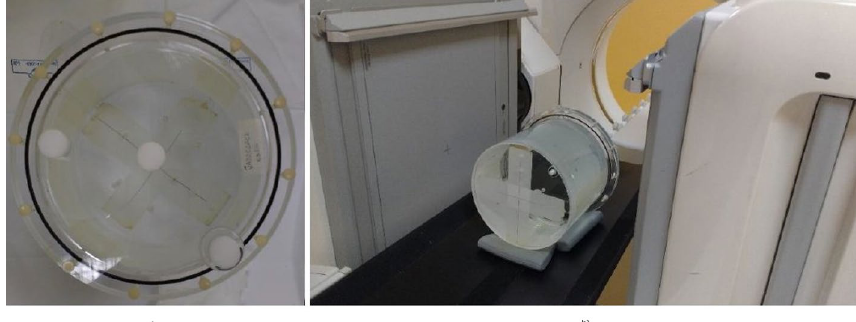
Fig. 1 Experimental Setup Example of experimental configuration: a the uniform phantom is shown; b the acquisition geometry for Tc-99 m